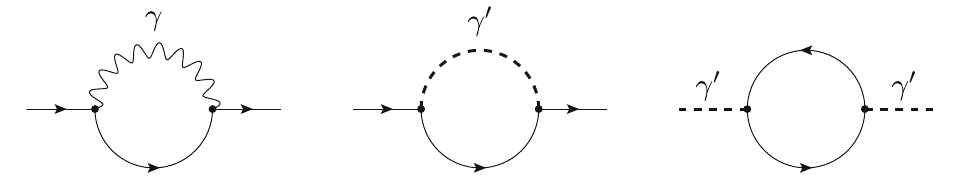
Fig. 7 One-loop diagrams contributing to the self-energy of the quark ( left and middle ) and of the fdf -scalar ( right ). The diagram with the internal fdf scalar vanishes according to the ( − 2 (cid:3)) -SRs